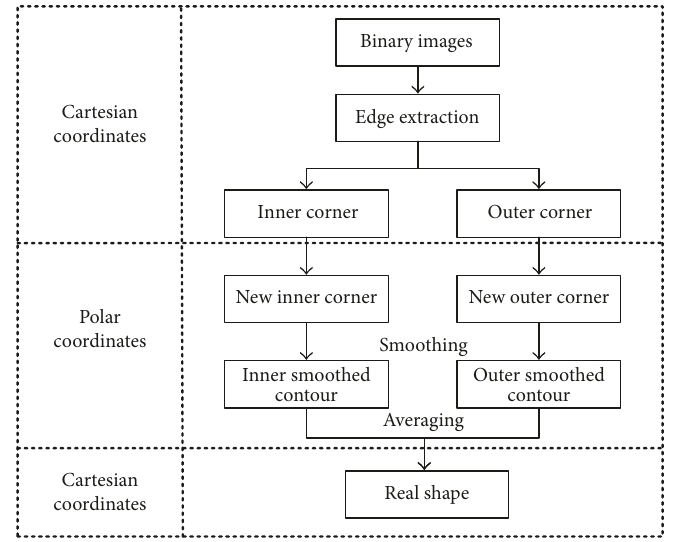
Figure 8: The flowchart of the process for extracting the real shape of particles.